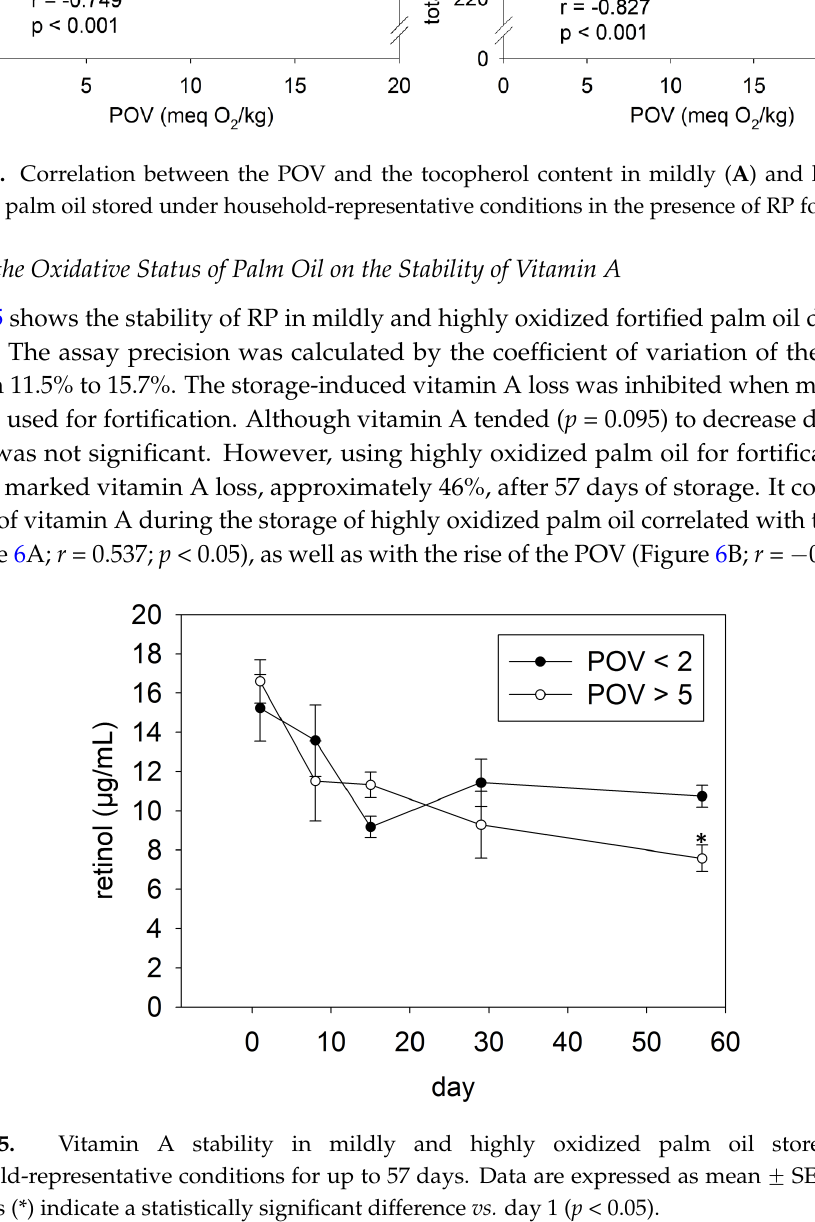
Figure 4. Correlation between the POV and the tocopherol content in mildly ( A ) and highly ( B ) oxidized palm oil stored under household ‐ representative conditions in the presence of RP for 57 days.